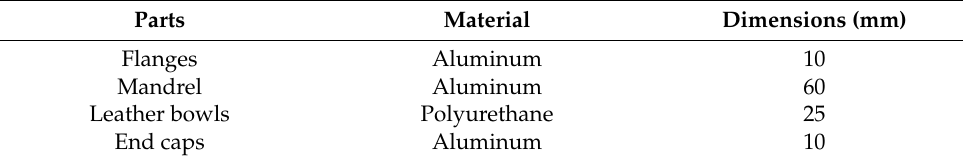
Figure 3. Pipeline robot with 2, 4, and 6 bowls. Table 2. Pipeline robot components.